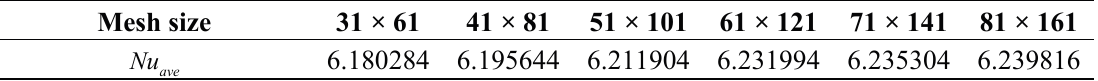
Table 1. Comparison of the average Nusselt number